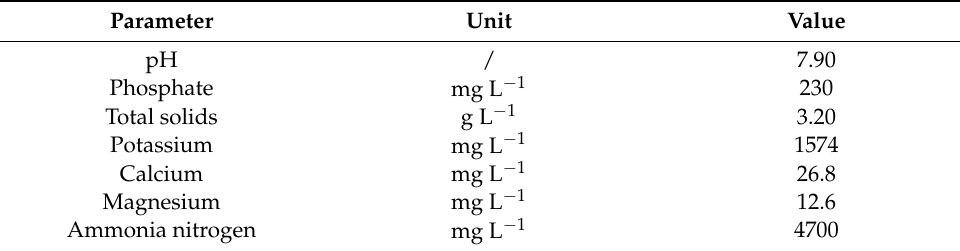
Table 3. Characteristic of anaerobic digestate in this